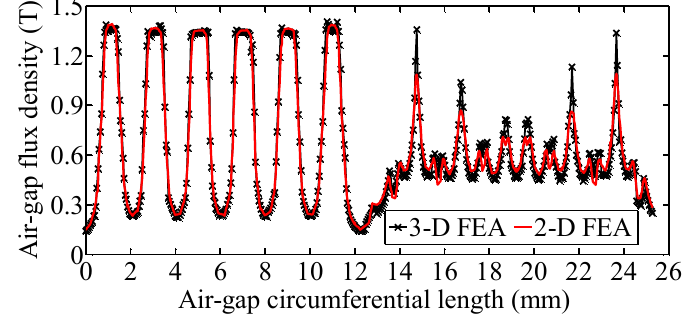
Figure 11. Comparison of air-gap PM flux density of sub-motor1 by 3-D and 2-D FEA.